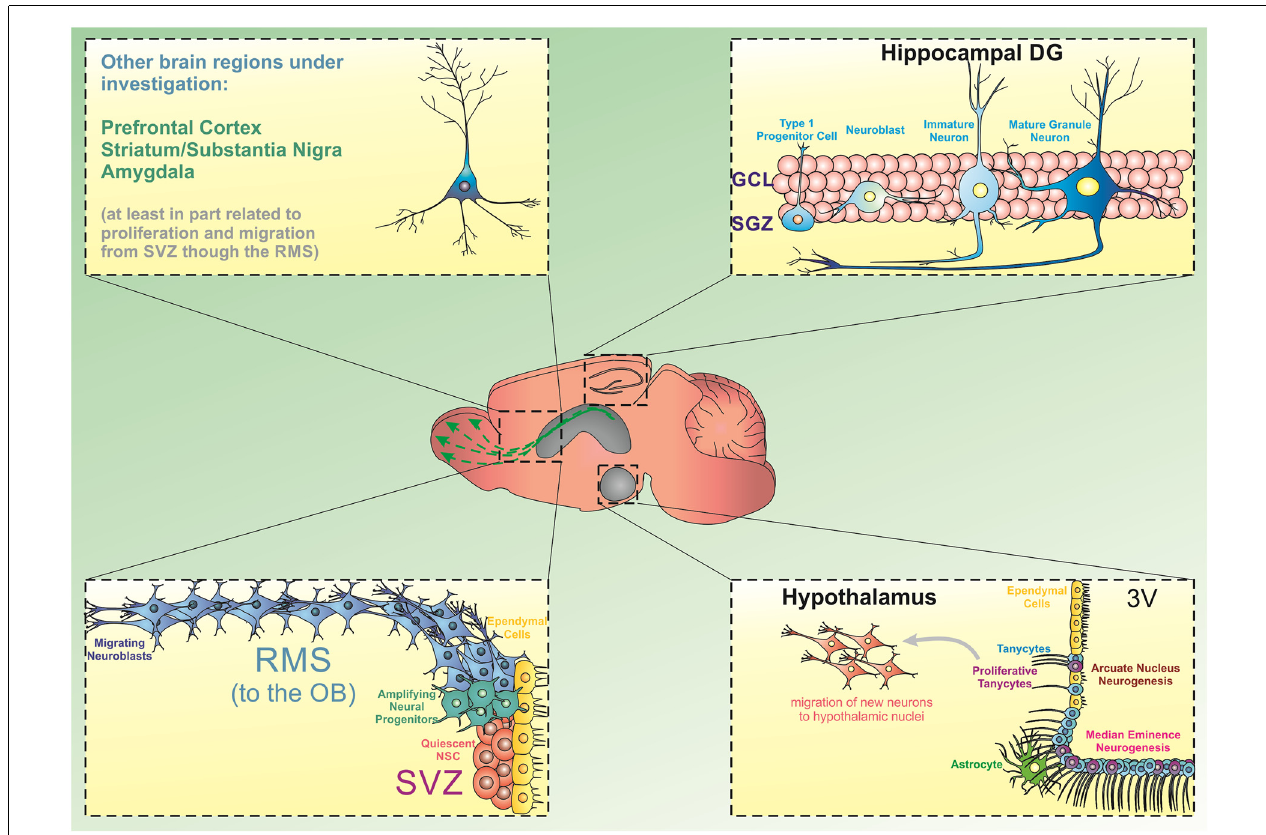
FIGURE 1 | Source of progenitor cells in different brain regions. The generation of new neurons from stem/progenitor cells has been extensively described in the hippocampal dentate gyrus (DG) and the subventricular zone/olfactory bulb (SVZ/OB). In the DG, precursor cells located in the subgranular zone divide and give rise to amplifying cells, which can commit to a neuronal phenotype and move into the granule cell layer to integrate into existing hippocampal circuitries. Similarly, dividing progenitor cells in the SVZ can differentiate into neural progenitors and migrate through the rostral migratory stream (RMS) towards the OB. Besides these two regions, there is emerging evidence indicating that the hypothalamic arcuate nucleus and the median eminence present neurogenic capacity. Particularly, a subpopulation of tanycytes has been shown to display neurogenic characteristics in these subregions. Additionally, experimental evidence has suggested that progenitor cells can deviate from the RMS and differentiate and mature into other brain regions including the prefrontal cortex, striatum, substantia nigra, and